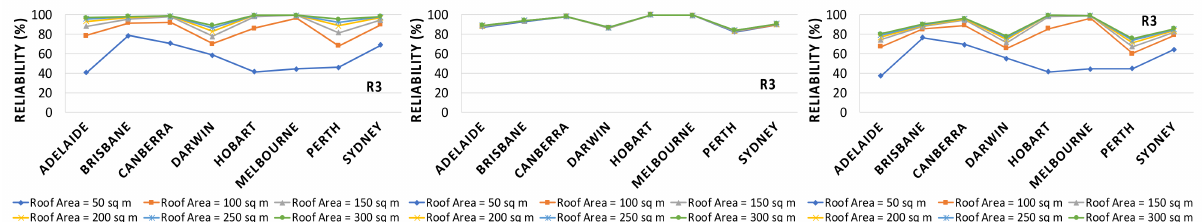
Figure 9. Reliability–roof area relationships for both the historical and future periods (TLD, irrigation and combined use).